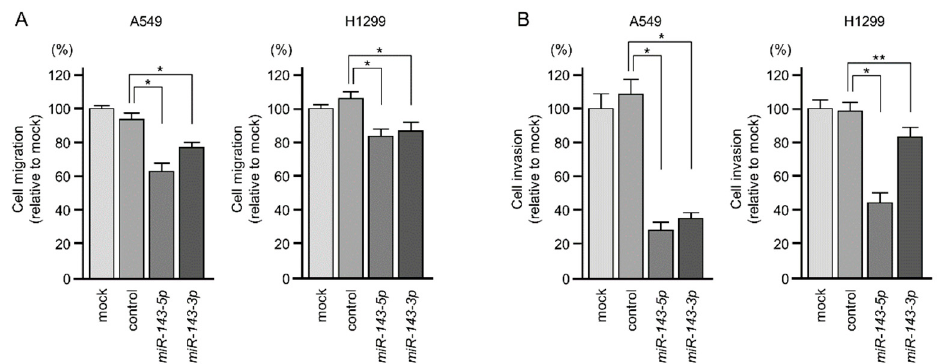
Figure 3. Cell migration and invasion assays in LUAD cells with ectopic expression of miR-143-5p and miR-143-3p . Cells were transfected with miR-143-5p and miR-143-3p . ( A ) Cell migration was measured (48 h after wounding the cells) by wound healing assays (* p < 0.001). ( B ) Cell invasion was determined (48 h after seeding cells into the chamber) by Matrigel invasion assays (* p < 0.001, ** p < 0.05).